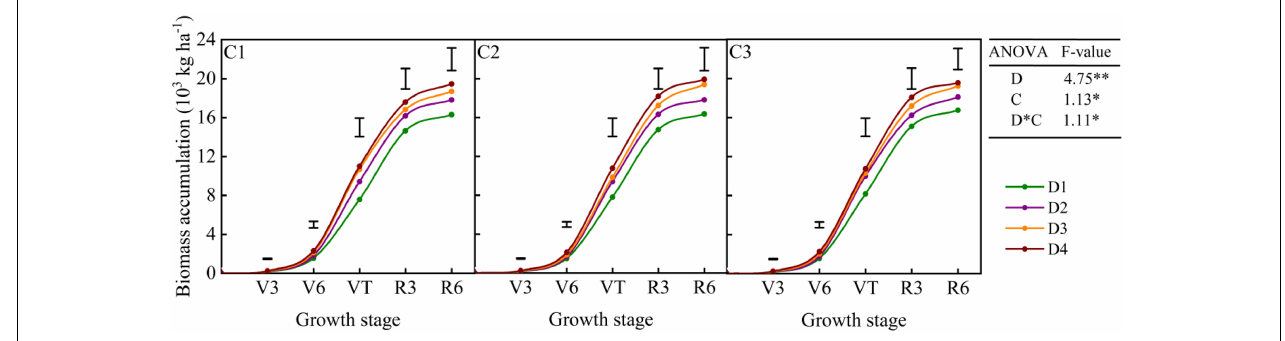
FIGURE 2 | Aboveground biomass accumulation of dryland maize under different planting densities and cultivar treatments. D1: 52,500 plants ha − 1 ; D2: 67,500 plants ha − 1 ; D3: 82,500 plants ha − 1 ; D4: 97,500 plants ha − 1 ; C1: Yuyu22; C2: Zhengdan958; C3: Xianyu335; D, planting density; C, cultivar. Data represent the average values over the experimental period (2013–2018). Vertical bars represent the least significant difference (LSD) value at p < 0.05.